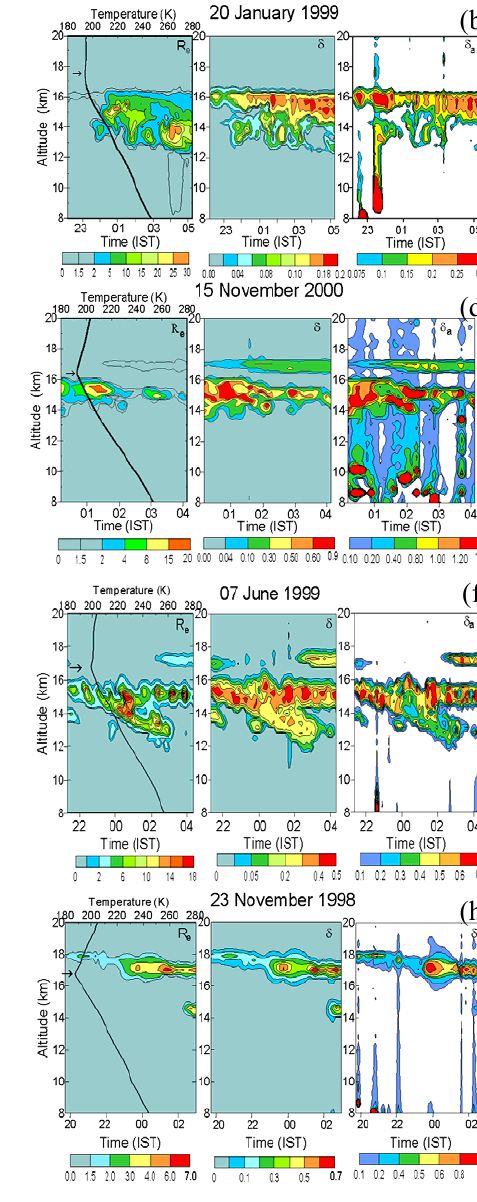
Fig. 2. Different forms of cirrus manifestations observed at the tropical station Gadanki. In each set the first panel shows the contour plot of the effective backscatter ratio ( R e ) , the middle panel that of volume depolarization ratio ( δ) and the end panel that of the particulate depolarization ratio ( δ a ) . The altitude profile of temperature derived from MST radar data is superposed on the first panel to depict the cold point (tropopause)